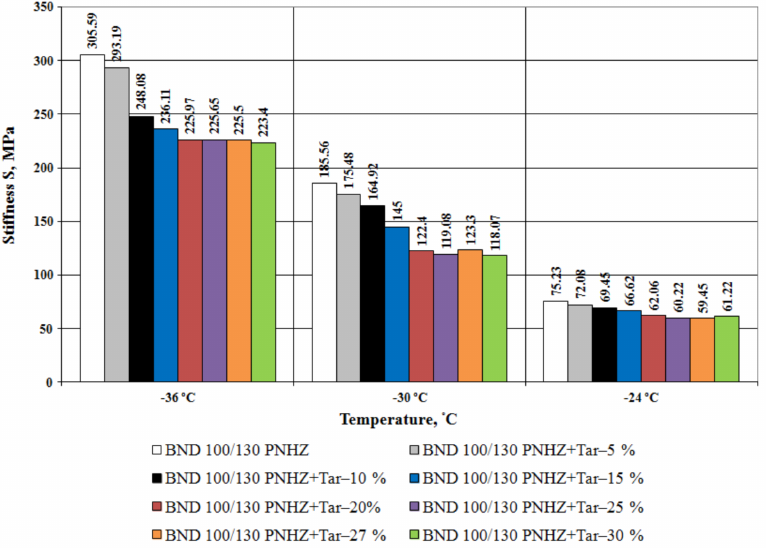
Figure 2. Bitumen stiffness at various tar contents and different